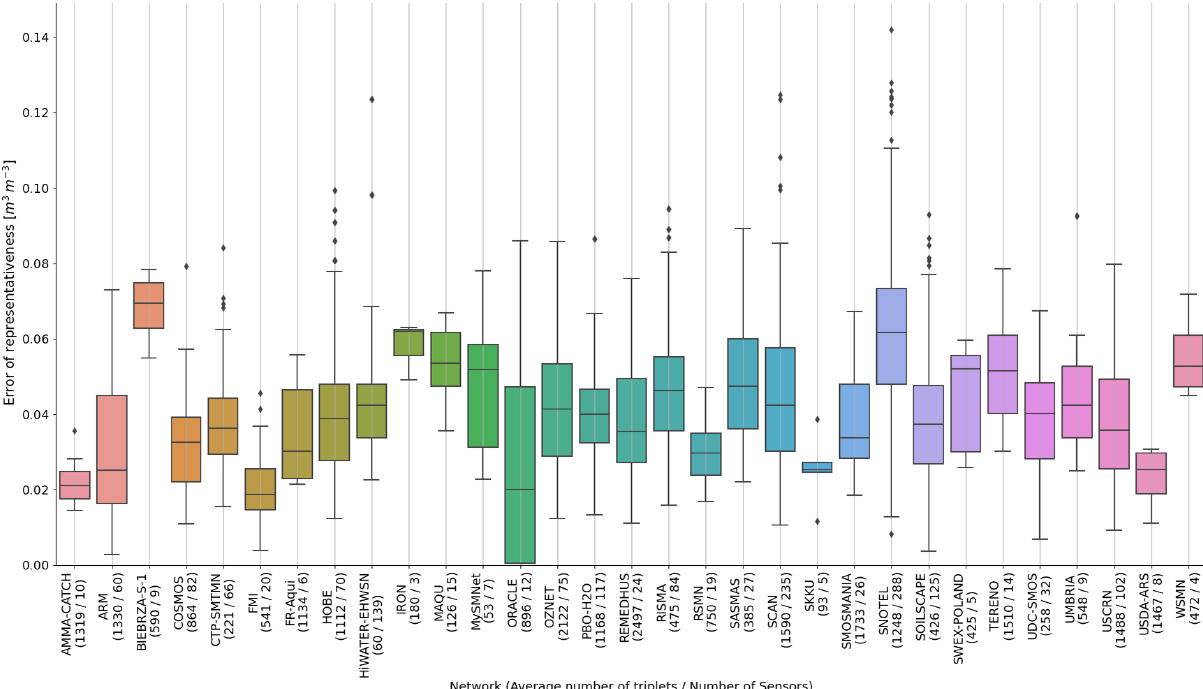
Figure 7. Representativeness errors of ISMN networks calculated with triple collocation analysis using top-layer ERA5 volumetric soil water and the ESA CCI SM v05.2 passive product. Values in parentheses show the average number of triplets per time series and the total number of sensors, respectively, for each network. Following Dorigo et al. (2010), we only used triplets with a Spearman correlation > 0.2 between each respective data set pair in the calculation.